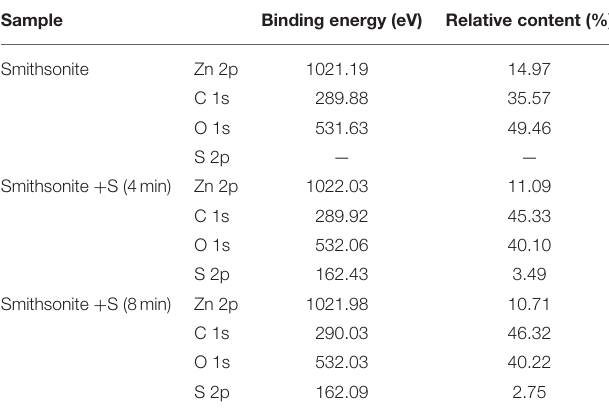
TABLE 2 | The atomic concentrations of smithsonite samples at different sulfurization